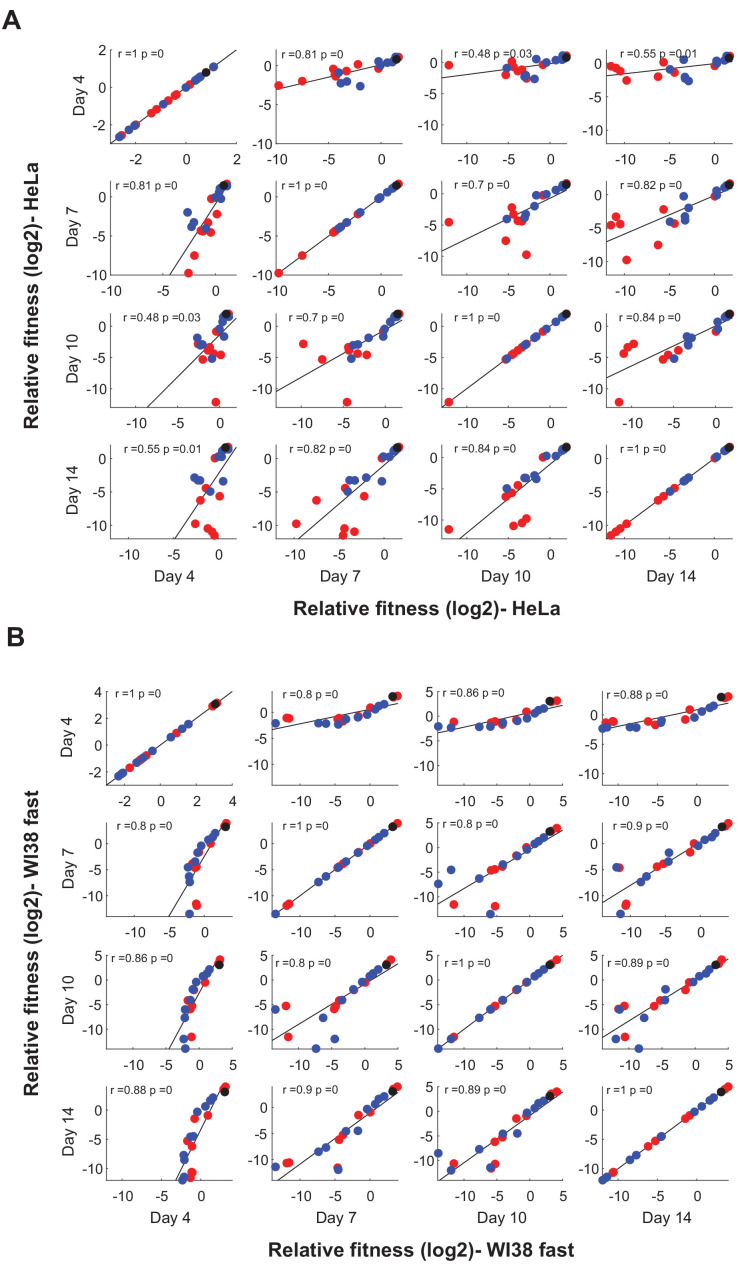
Comparison between relative fitness of tRNA- targeted cell in different time points of iCas9 induction.(A-C) Scatter plots representing the correlation between the relative fitness of the CRISPR-targeted tRNA variants in different days along the cell competition (days 4, 7, 10, and 14). The colors depict the tRNA family (red-proliferation-tRNAs; blue-differentiation-tRNAs; black-pseudo tRNA). The correlation coefficient r and p-values are detailed for each scatter plot. (A) HeLa cells (B) WI38 fast cells (C) WI38 slow cells.